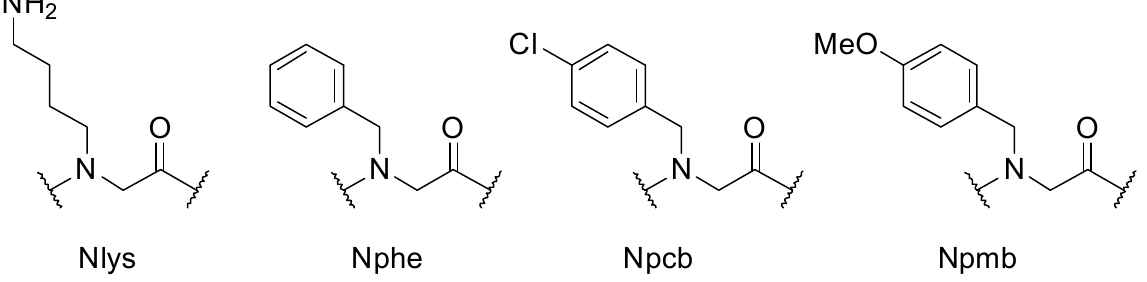
Figure 3. Annotation of the peptoid monomers. Nlys = N